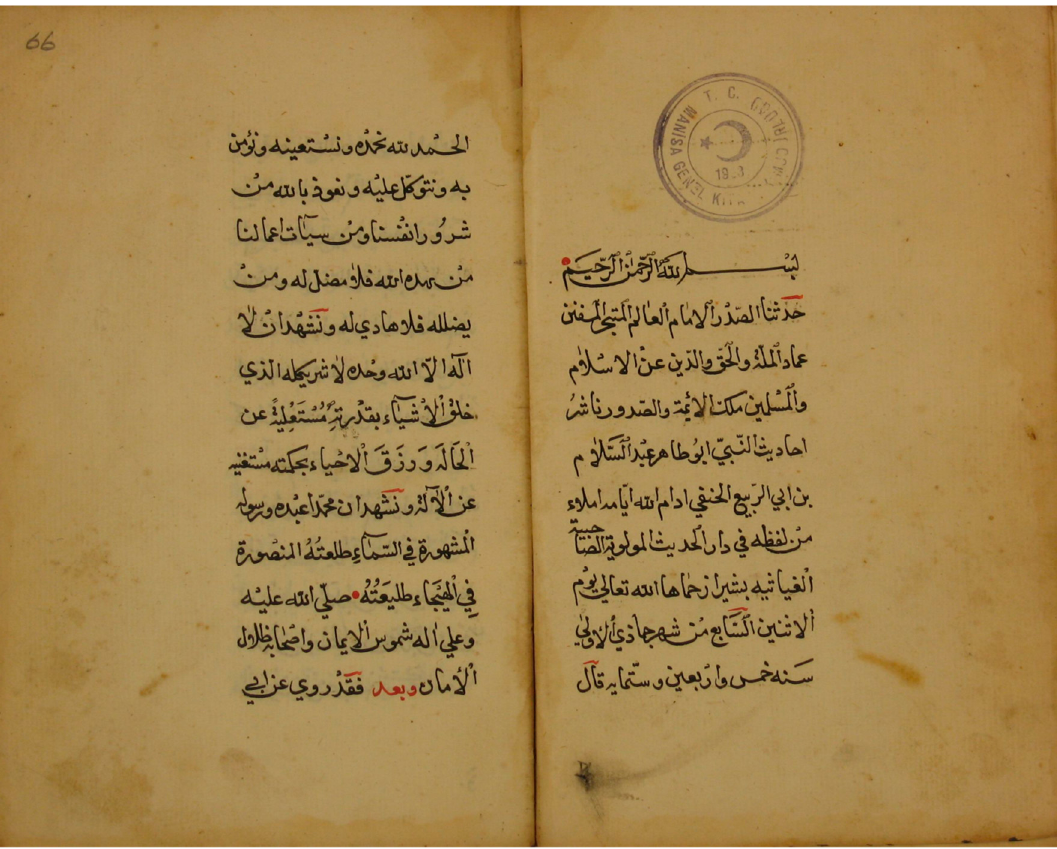
Figure A4. MS Manisa 45 Hk 1080, ff.65b–66a (preface of Al-Arba ʿ ū n ).